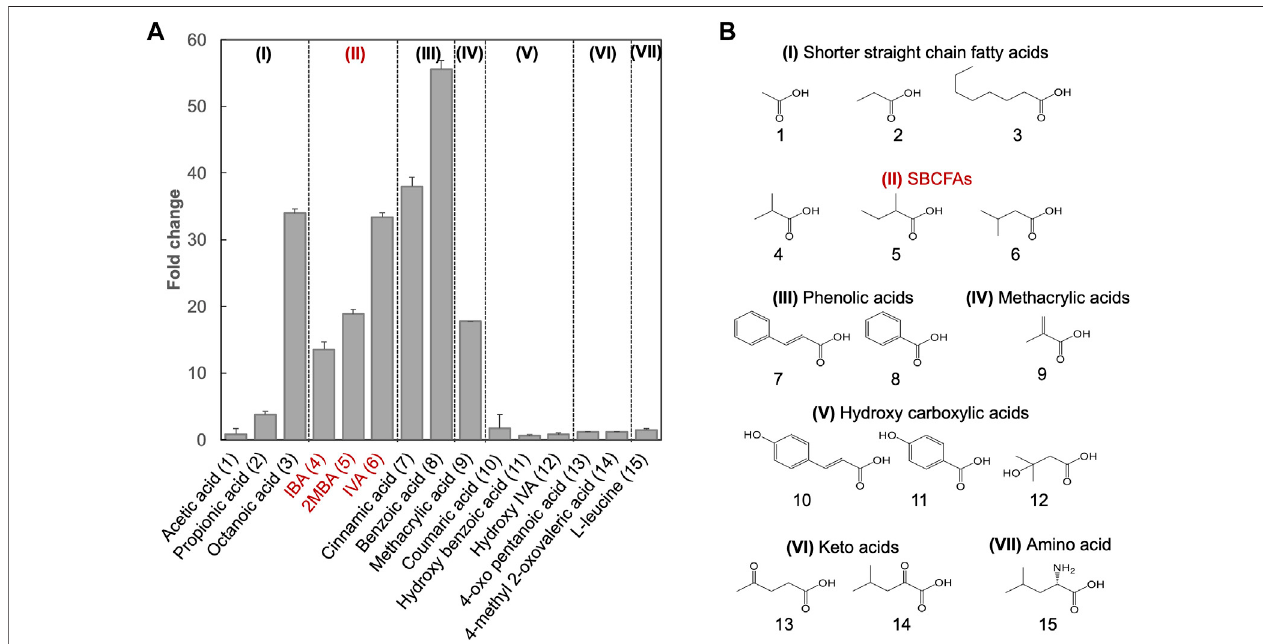
FIGURE2| SubstratespectralanalysisofbiosensorBY4741-S LCA . (A) ResponsesofBY4741-S LCA cells(foldchange)toweakorganicacidscategorizedbasedon the similarity of their chemical structures. GFP fl uorescence was measured after overnight incubation at 30 ° C and normalized to cell density (OD600) and further to controlwithoutweakorganicacidsupply.Valuesarethemeansofthreeindependentexperiments,andanerrorbarrepresentsastandarddeviationofthreeindependent experiments. (B) Molecularstructuresofthetestedweakacids,comprisingofshorterstraightchainfattyacids(I),andlipophiliccarboxylicacidderivativesincluding SBCFAs (II), phenolic acids (III), methacrylic acid (IV), hydroxy carboxylic acid (V), keto acids (VI) and amino acid Leucine (VII). Their numbers are indicated, and SBCFAs are highlighted in red.